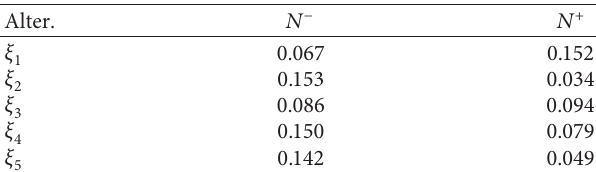
Table 20: Separation